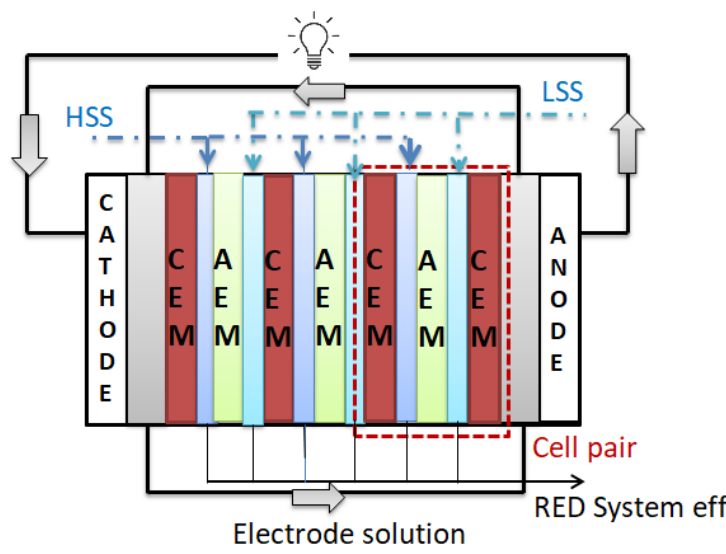
Figure 1. Schematic of a RED system (HSS: High saline solution, LSS: Low saline solution) (Adapted from [9]).